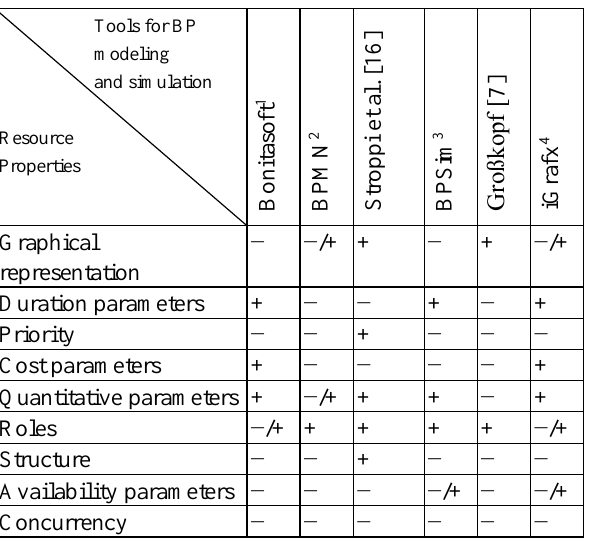
T OOLS AND M ETHODS FOR S UPPORT OF R ESOURCE M ODELING Tools for